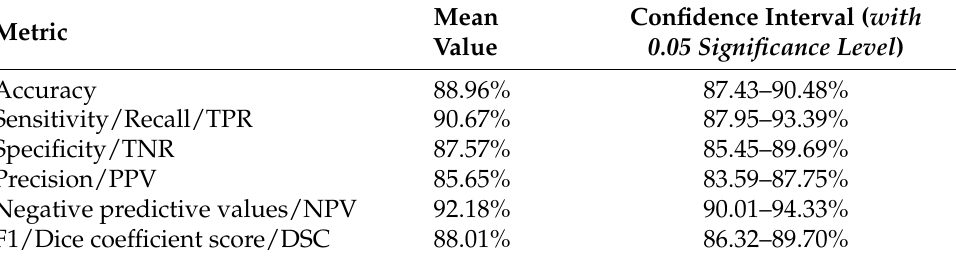
Figure 4. Observations w.r.t each of the 10 folds: ( A ) Loss vs. number of epochs ( B ) Accuracy vs. number of epochs. Table 2. Performance evaluation of proposed approach with standard